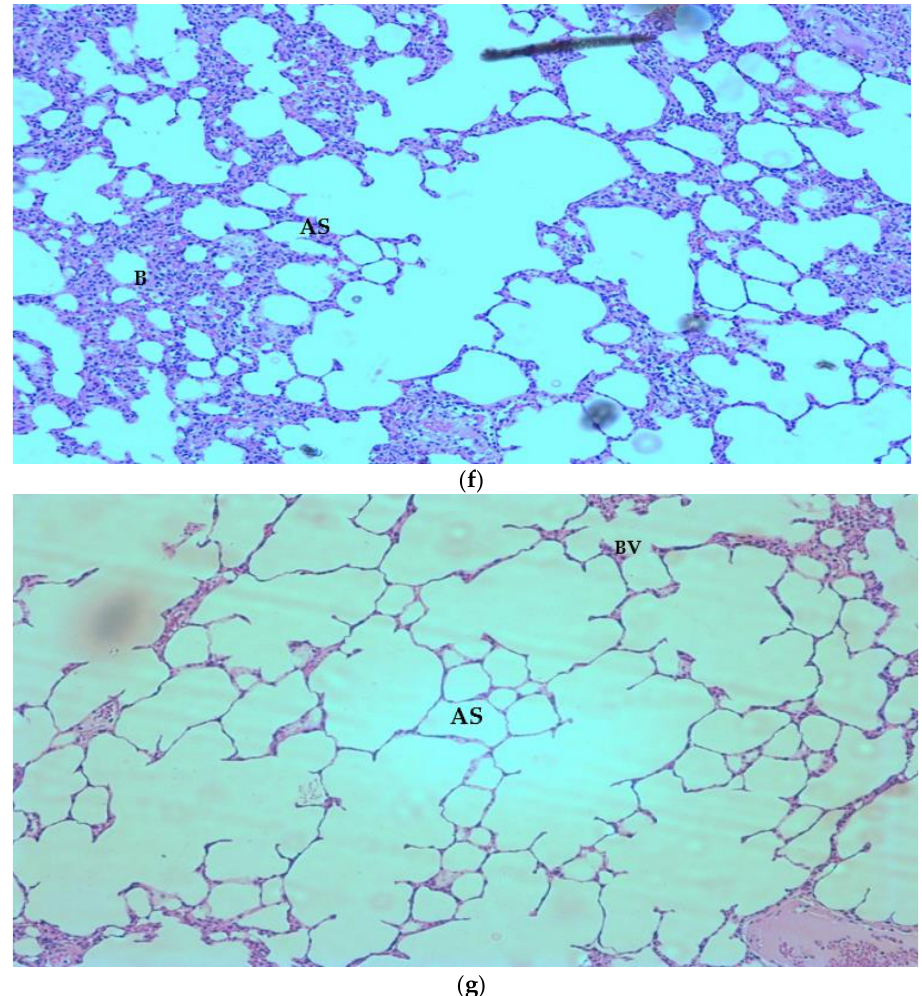
Figure 4. ( a ) Histological examination of lung tissue from normal animals showing alveolar sac (AS), alveolus (A), and blood vessel (BV) (×100). ( b ) Lung tissue histology from P. aeruginosa control. A distortion in the pulmonary architecture can be observed with thickened interalveolar septa (black arrows) and mononuclear cellular infiltration (red arrow), interstitial exudates (blue arrow), ruptured interalveolar septa with large irregular emphysematous air spaces (star) are seen (×100). ( c ) Histological examination of lung tissue from frankincense oil-treated group after infection with P. aeruginosa . A relatively protected pulmonary tissue showing alveolar sac (AS), blood vessel (BV) with less mononuclear infiltration, reduced thickness of alveolar sacs, and less interalveolar rupture (×100). ( d ) Histological examination of lung tissue from the gentamicin-treated group after infection with P. aeruginosa . A relatively protected pulmonary tissue showing alveolar sac (AS), bronchiole (B), and blood vessel (BV) with less mononuclear infiltration, reduced thickness of alveolar sacs, and less interalveolar rupture (×100). The effect was similar to that observed with frankincense oil. ( e ) Histological examination of lung tissue from MRSA control. A distortion in the pulmonary architecture can be observed with thickened interalveolar septa (black arrows) and mononuclear cellular infiltration (red arrow), interstitial exudates (blue arrow), ruptured interalveolar septa with large irregular emphysematous air spaces (star) are seen (×100). ( f ) Histological examination of lung tissue from frankincense oil-treated group after infection with MRSA. A relatively protected pulmonary tissue showing alveolar sac (AS), and bronchiole (B), with less mononuclear infiltration, reduced thickness of alveolar sacs, and less interalveolar rupture (×100). ( g ) Histological examination of lung tissue from imipenem treated group after infection with MRSA. A relatively protected pulmonary tissue showing alveolar sac (AS), and blood vessel (BV), with less mononuclear infiltration, reduced thickness of alveolar sacs, and less interalveolar rupture (×100).